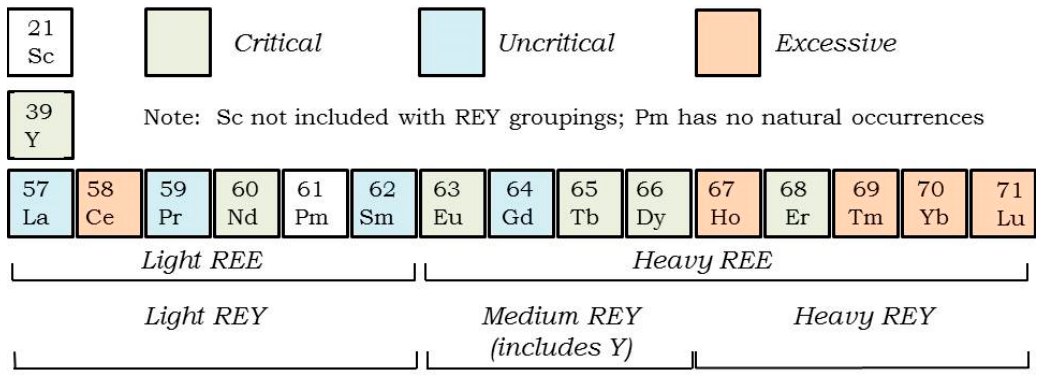
Figure 3. Divisions of lanthanides and yttrium into light, medium, and heavy REY; light and heavy REE; and critical, uncritical, and excessive groups (after Seredin [50] and Seredin and Dai [9]).